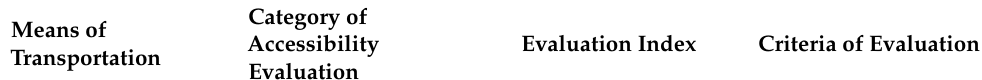
Table 1. Setting and criteria of evaluation